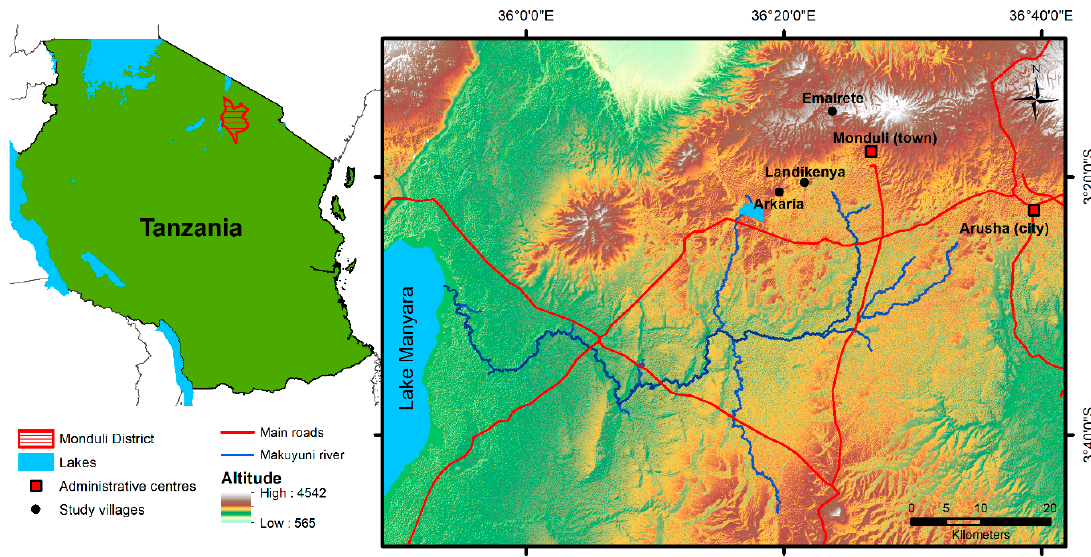
Figure 1. Monduli District, Tanzania, showing location of case study communities .